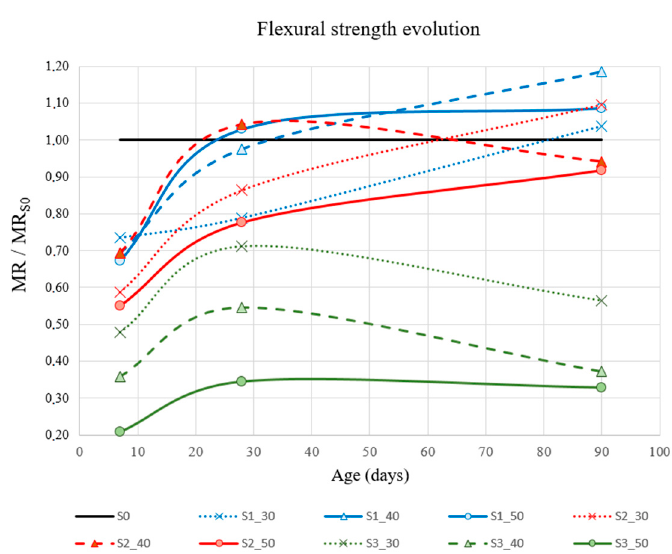
Figure 5. Flexural strength evolution (MR/MR S0